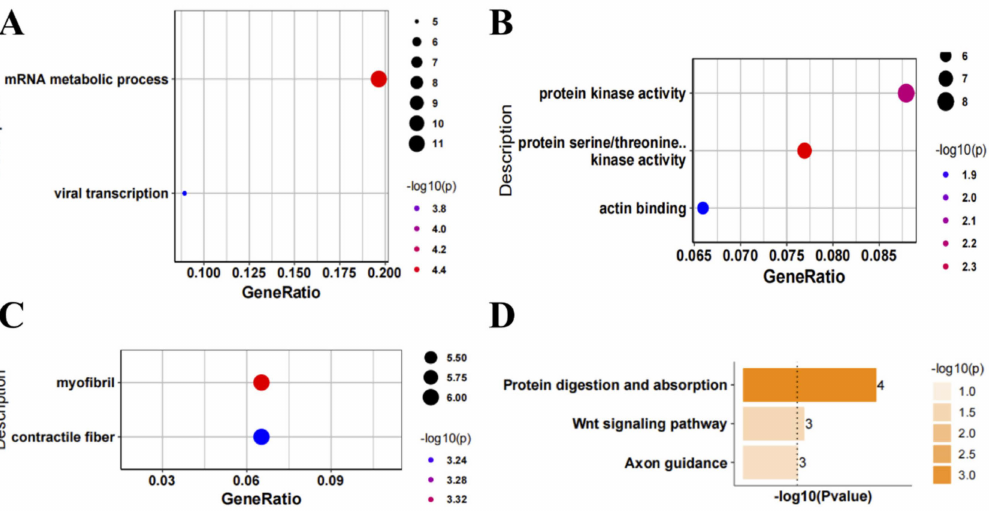
Figure 3. Functional enrichment analysis of down-regulated genes in nerve tissue of amyotrophic lateral sclerosis (ALS) patients. ( A ) Gene Ontology (GO) biological process, ( B ) GO molecular function, ( C ) GO cellular component, and ( D ) Kyoto Encyclopedia of Genes and Genomes (KEGG) analysis of down-regulated genes in nerve tissue of patients with ALS. The number on the right represents the number of differentially expressed